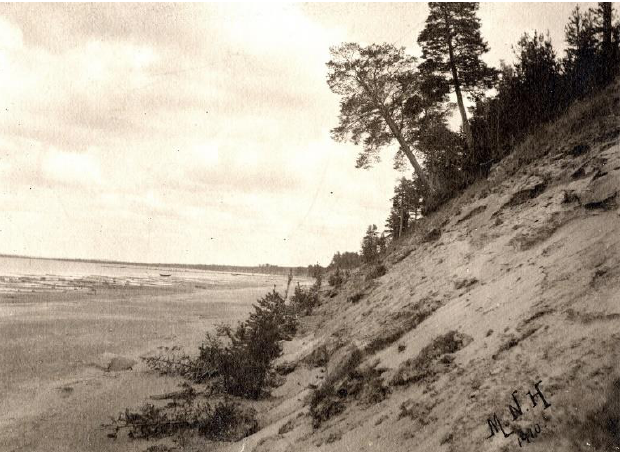
Figure 2. Banks of Lake Oulujärvi, northern Finland, in 1910 (unidentified photographer M.N.H.; photo: Museum of Kainuu, northern Finland). Today the banks are covered with abundant vegetation.